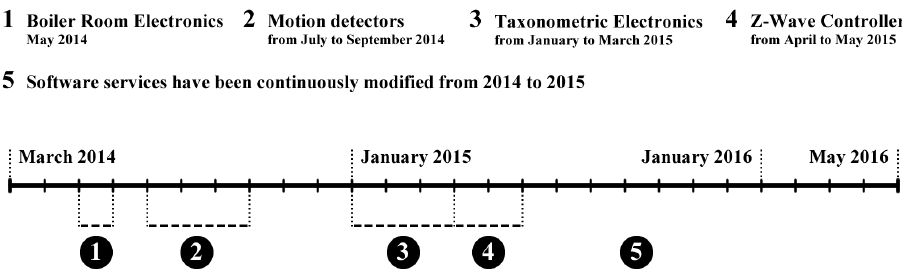
Figure 4. A timeline of modifications during the testing period. Source: Authors.